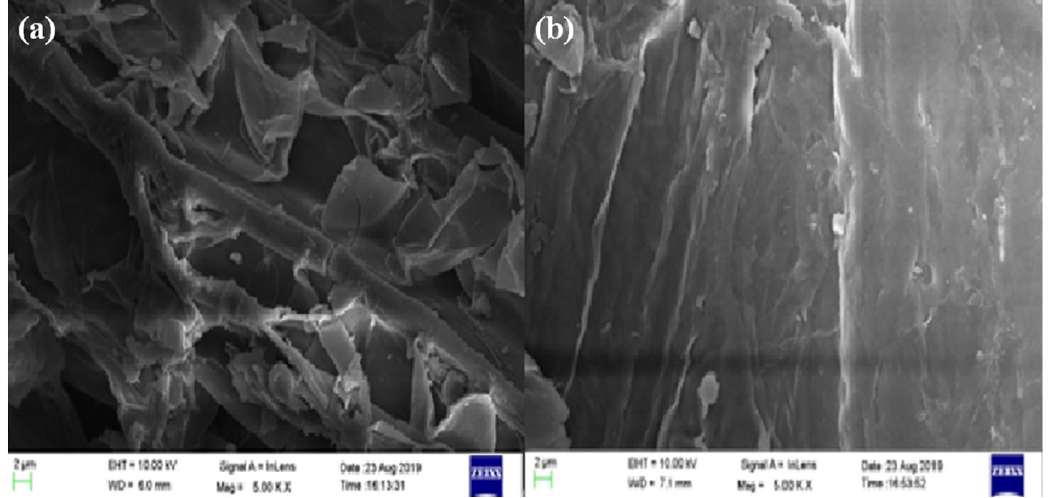
Fig. 5. FESEM results of (a) Raw Wheat Straw, (b)